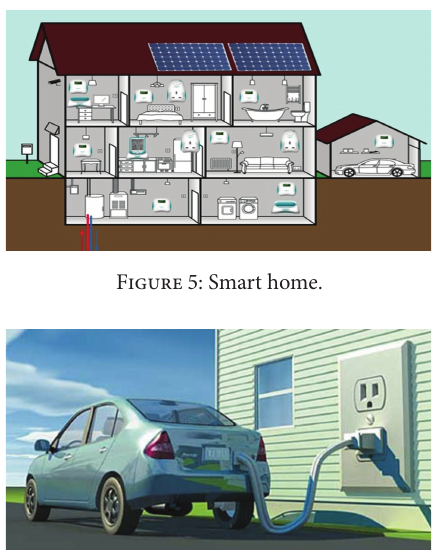
Figure 6: Plugging-in electric or hybrid vehicle.